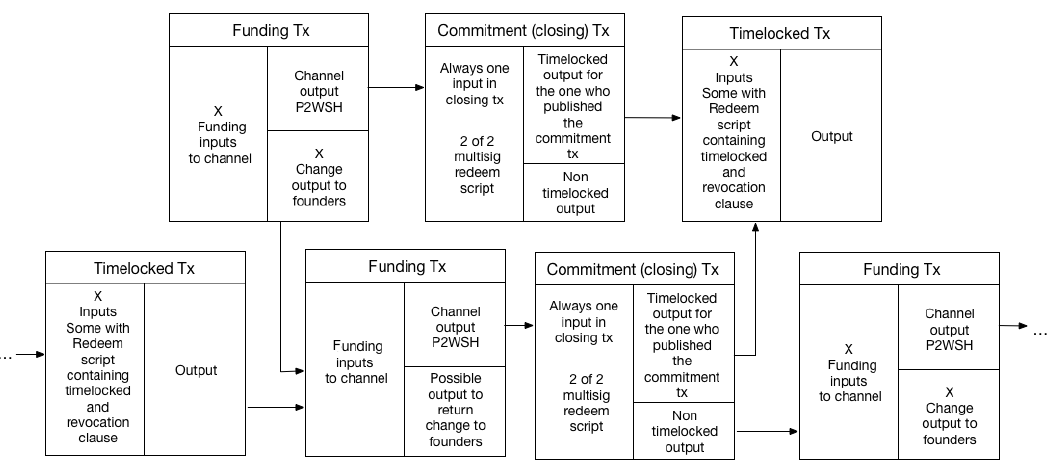
Figure 9. Connected channel